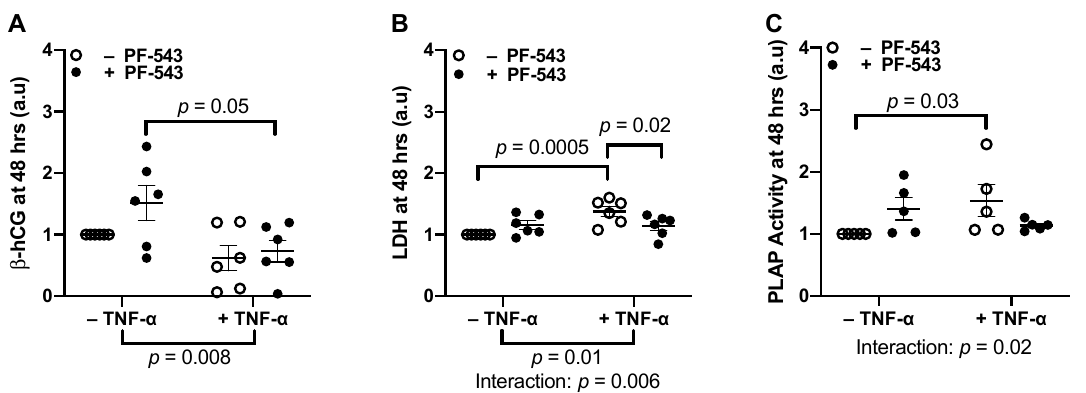
Figure 4. Inhibiting SphK1 with PF-543 diminished TNF- α effects on LDH release and placental alkaline phosphatase (PLAP)-positive shed particles but not on beta-human chorionic gonadotropin ( β -hCG) secretion at 48 hrs. Explants were pre-cultured for 4 days prior to treatment with 10 ng/mL of TNF- ɑ , 1 μ M PF-543, a co- treatment of both or a no-treatment control for 48 h. Supernatants were centrifuged at 15,000 RPM for 15 min prior to analysis. ( A ) β -hCG released after 48 h was measured by ELISA. ( B ) LDH released into the supernatant after 48 h was measured with a colorimetric assay. ( C ): Non-centrifuged supernatants were analyzed for PLAP activity using an alkaline phosphatase activity assay. Results were normalized against total protein mass, and normalized values were graphed as a ratio of change from the untreated control explant cultures. Results were analyzed by two-way ANOVA with the two-stage linear step-up procedure of Benjamini, Krieger, and Yekutieli post-hoc test. ( n = 6 or n = 5, Mean ± SEM).